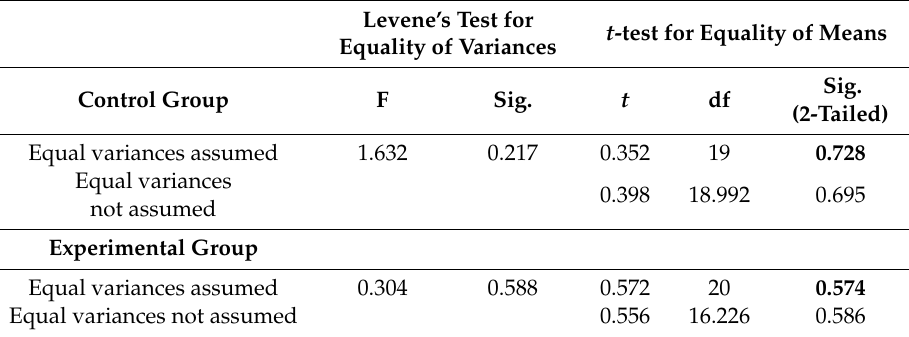
Table 10. Statistical analysis of student performance.